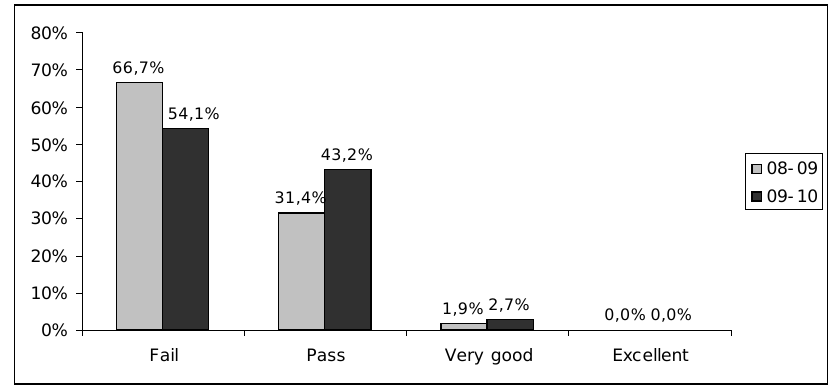
Figure 2. “Comparison of the GLOBAL results of the final theory exam of BLOCK III for academic years 08-09 and 09-10”. Source: authors